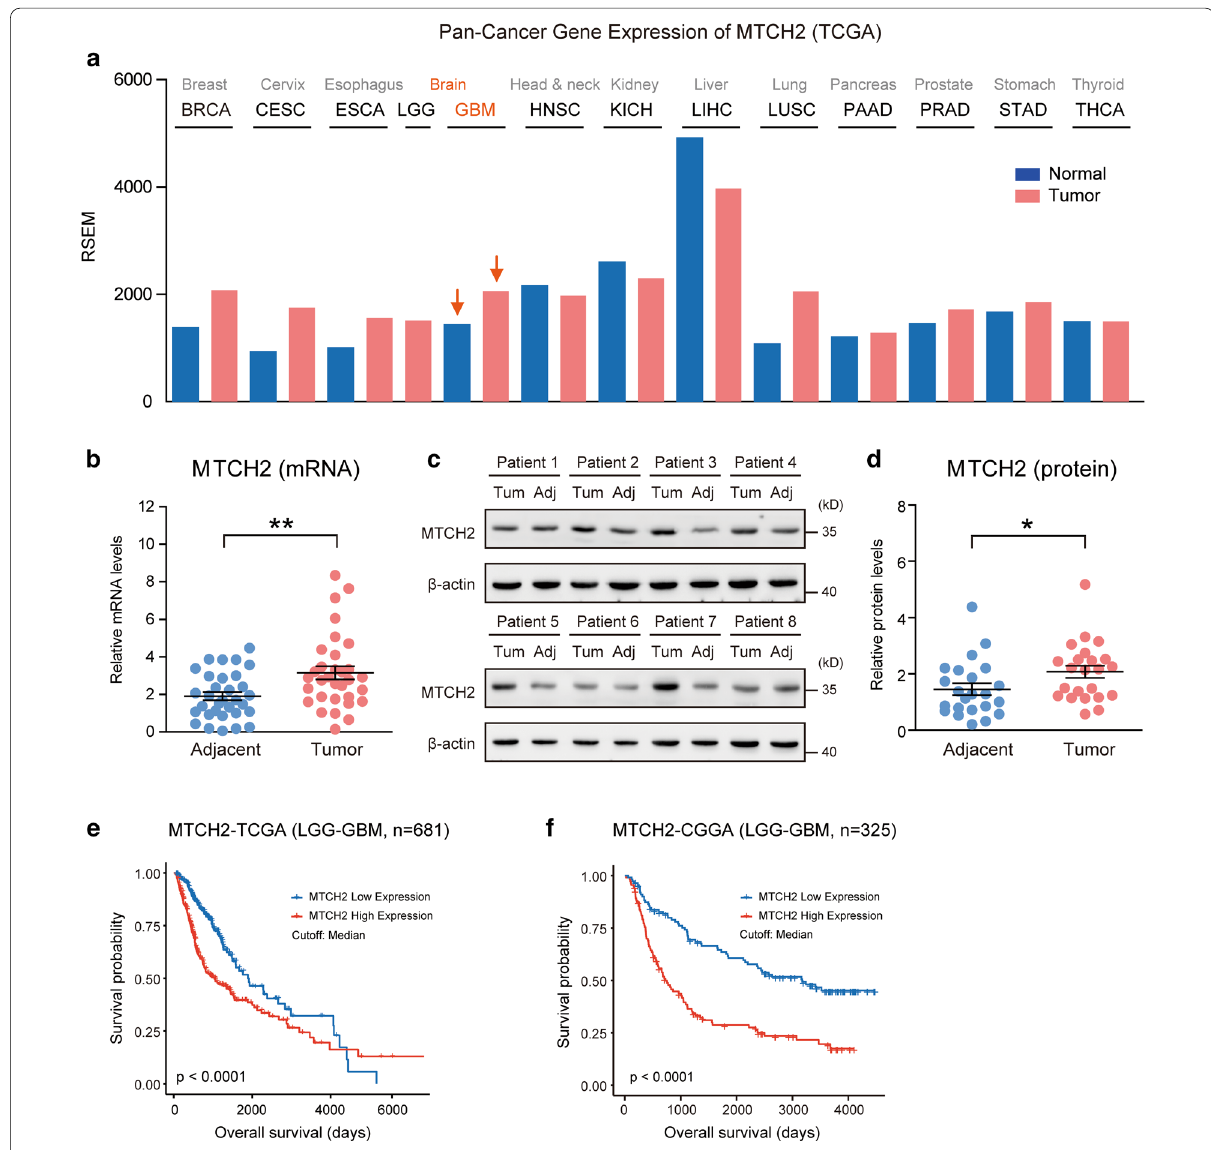
Fig. 1 MTCH2 expression is increased in glioma tissues and indicates poor prognosis. a A Pan-cancer diagram showing the increased MTCH2 expression in brain gliomas. b Real-time PCR results showing increased mRNA level of MTCH2 in glioma tissues compared to paired adjacent brain tissues (n 32). c , d Western blots ( c ) and quantifications ( d ) showing increased proteins of MTCH2 in glioma tissues compared to paired adjacent = brain tissues (n 23). e , f Survival analysis using clinical information from TCGA ( e ) and CGGA ( f ) dataset. Patients are divided into low and high = MTCH2 groups by median expression